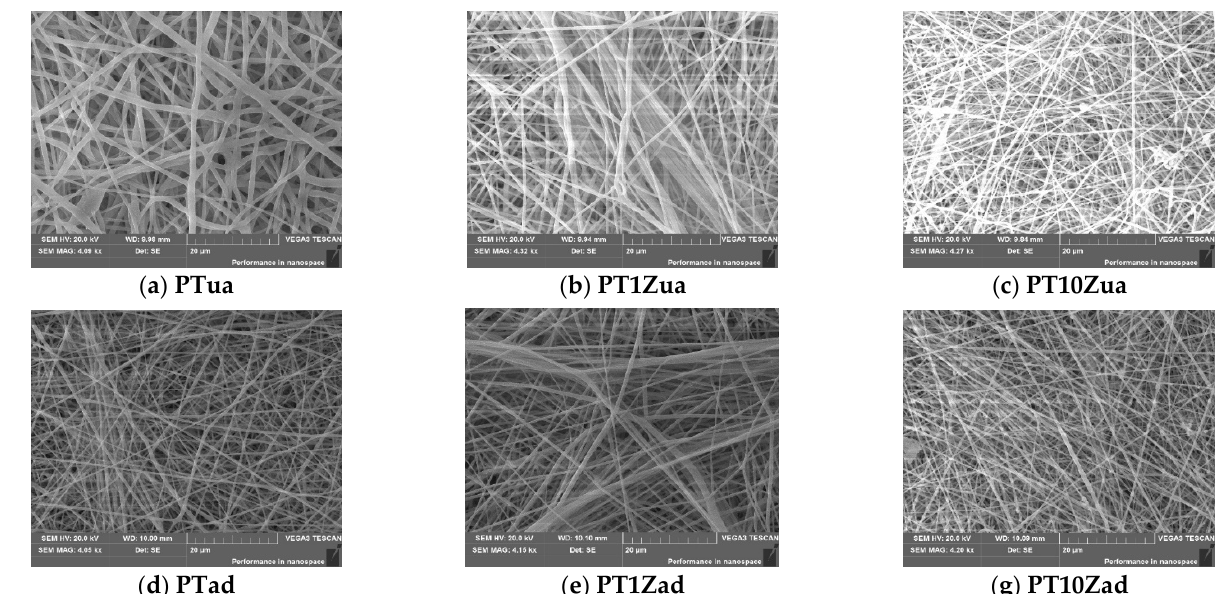
Figure 3. ( a – g ) SEM figures of the unannealed and annealed electrospinning membrane samples made of PVDF-TrFE doped with 0/1/10 wt% ZnO nanoparticles